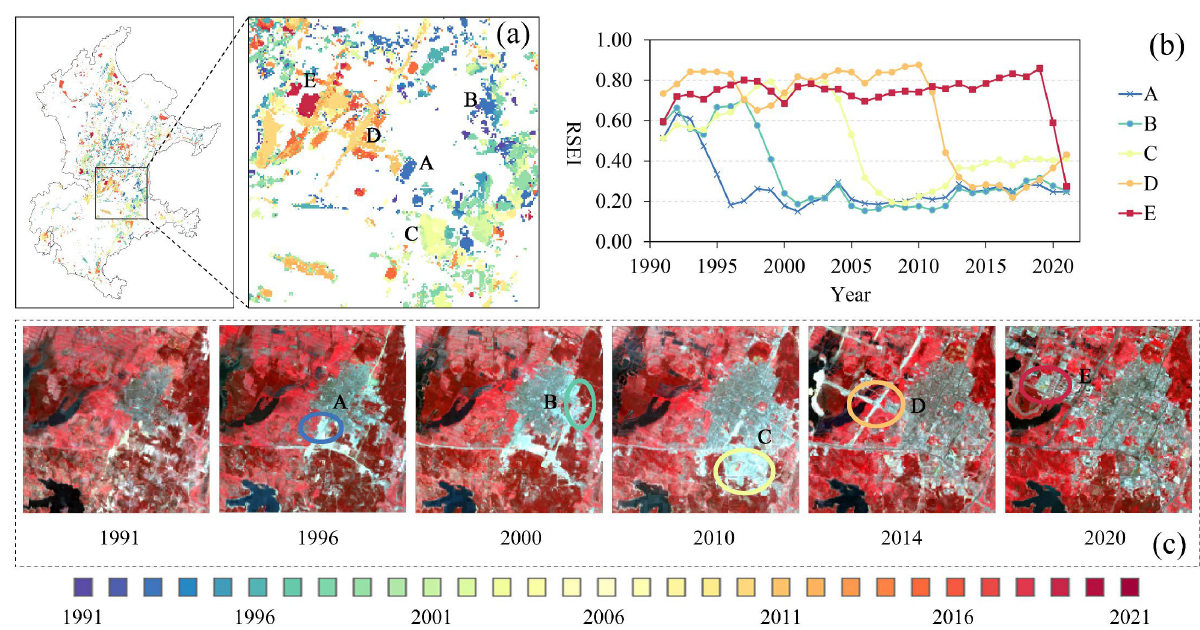
Figure 8. Impact of land use change on remote sensing-based ecological index (RSEI) (1991–2021) for Haitan Island. ( a ): enlarged example of the start time of the disturbance; ( b ): changes of RSEI in five regions; ( c ): example of Landsat images.